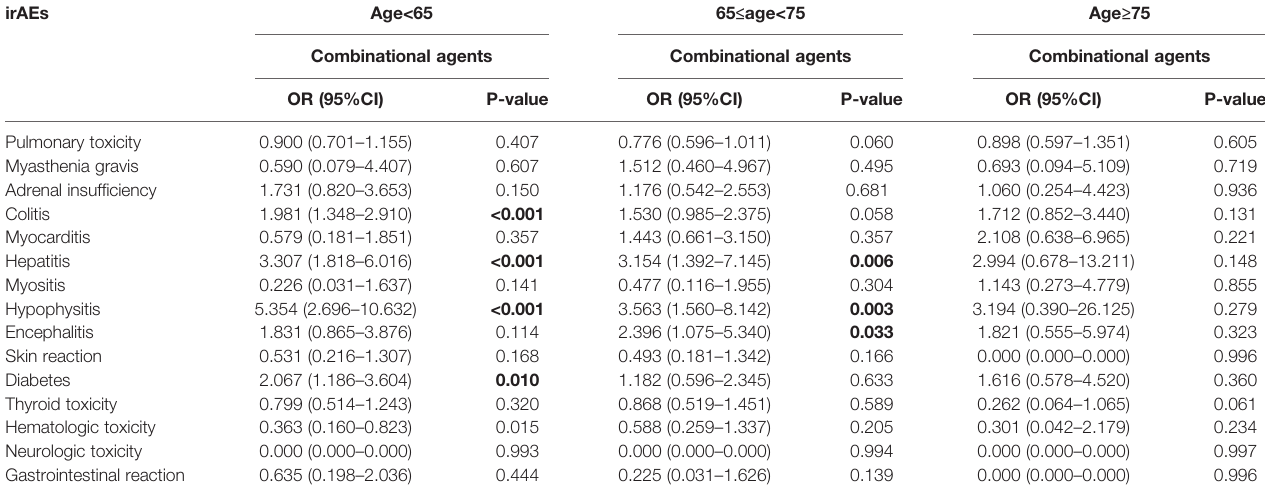
TABLE 3 | The severity of irAEs in patients with/without anti-CTLA4 agents.